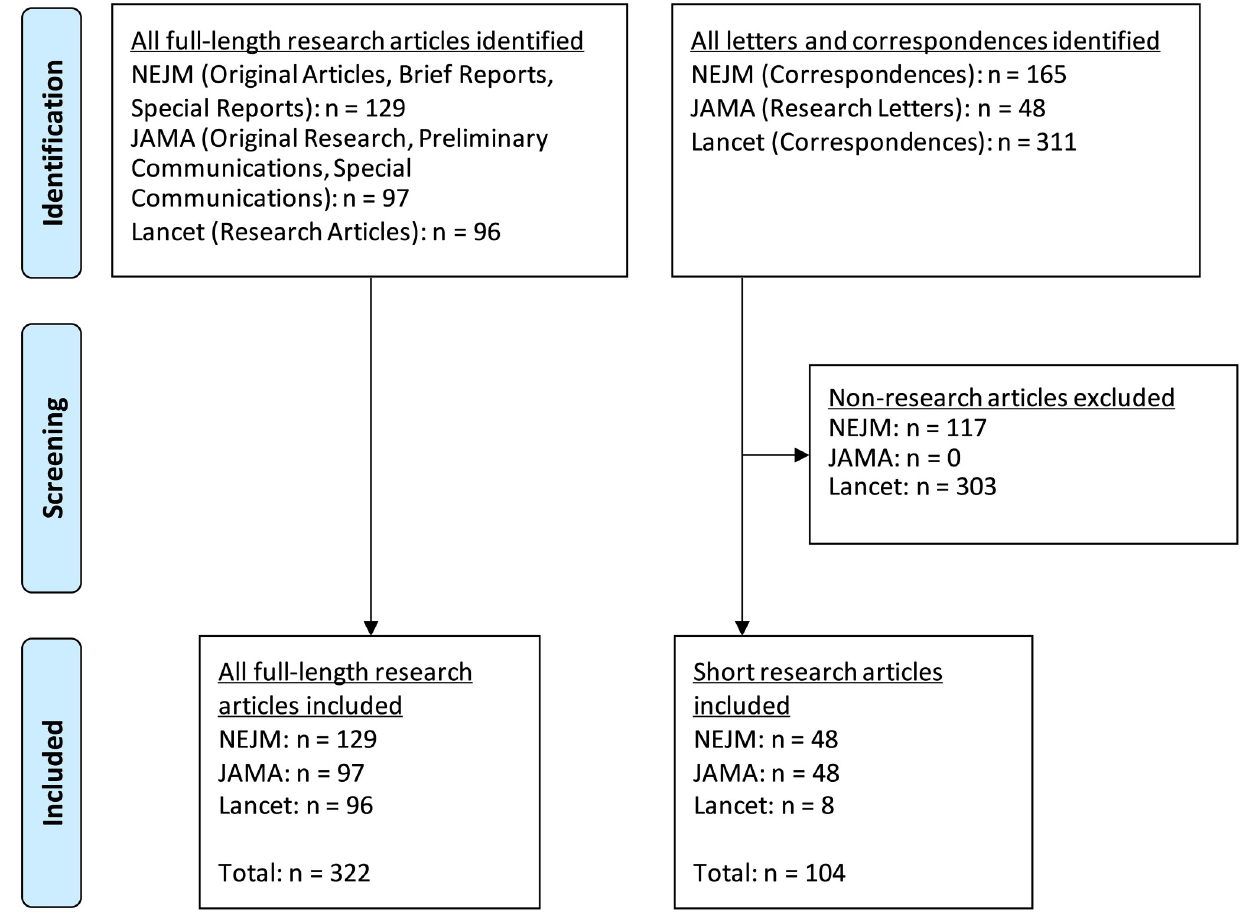
Fig 1. PRISMA flow